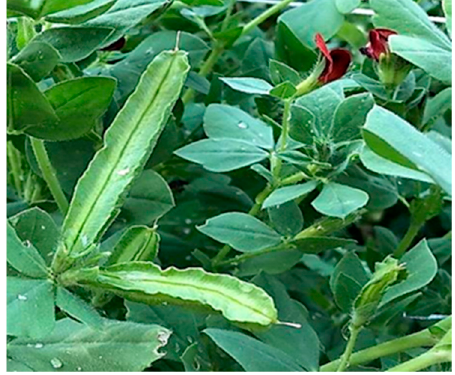
Figure 1. A Psophocarpus tetragonolobus plant.